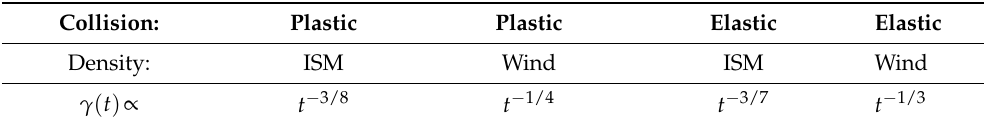
Table 2. The late time t-dependence of the bulk motion Lorentz factor of highly relativistic conical jets which decelerate by collision with the surrounding